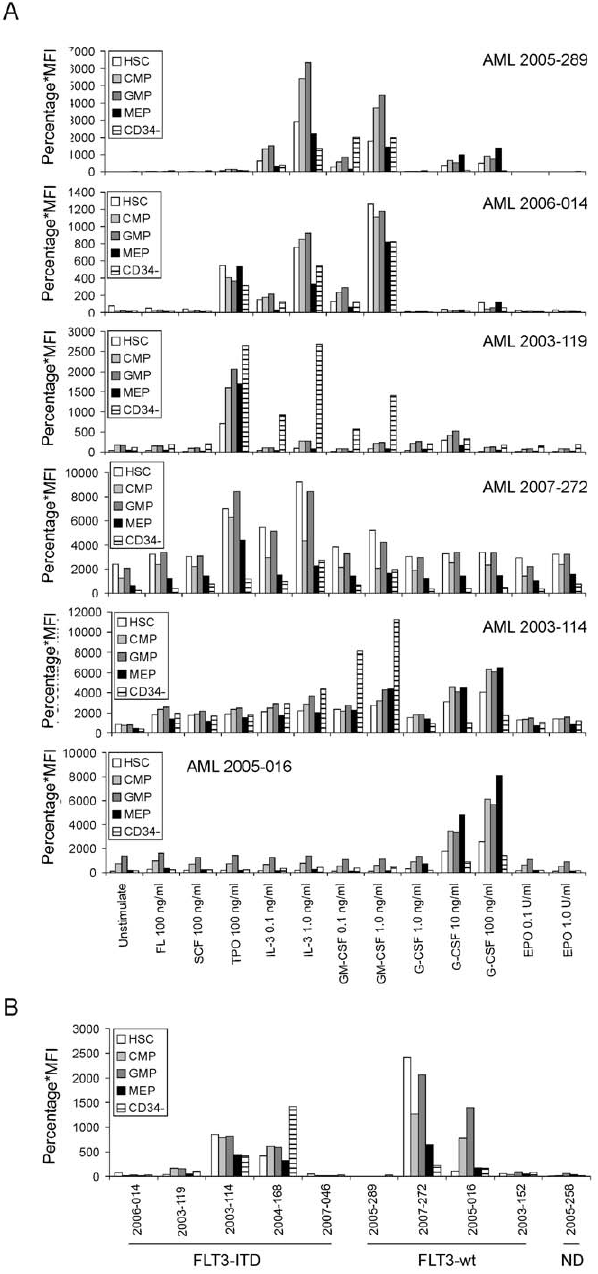
Figure 2. STAT5 phosphorylation in defined stem and progen- itor cell populations in AML cases. AML PB mononuclear cells (MNCs) were thawed and suspended at 1.5 6 10 6 /ml in HPGM for 2 hours at 37 u C. Cells were stimulated with cytokines for 15 minutes, followed by intracellular FACS. Panel (A) displays STAT5 phosphorylation in 6 AMLs with or without indicated cytokine stimulations. Panel (B) displays the basal levels of STAT5 phosphorylation (in unstimulated condition) of AML samples with FLT3-ITD versus FLT3-wild type. Data are presented as the multiplied value of the percentage of positive cells with the mean fluorescence intensity (MFI).